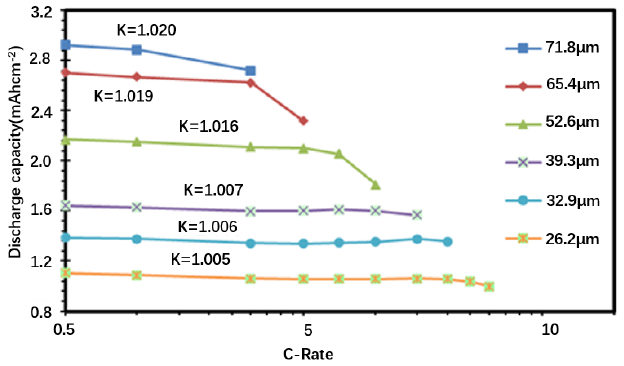
Figure 5. Peukert curves of cells with different electrode thicknesses.